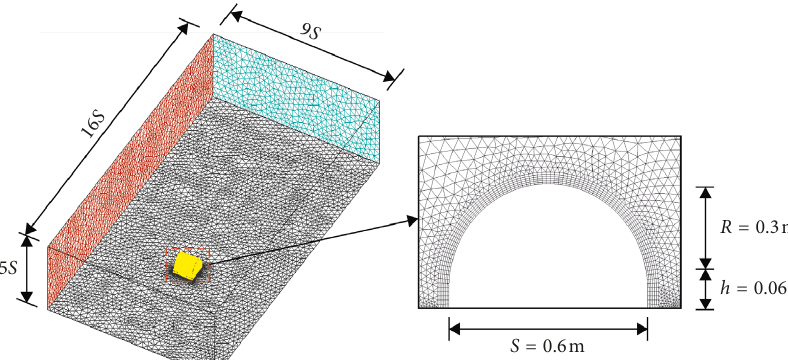
Figure 4: Computational domain and grid system used in this